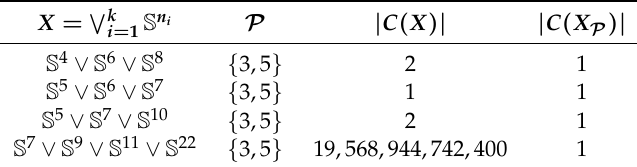
Table 2. The finite case for k ≥ 3.